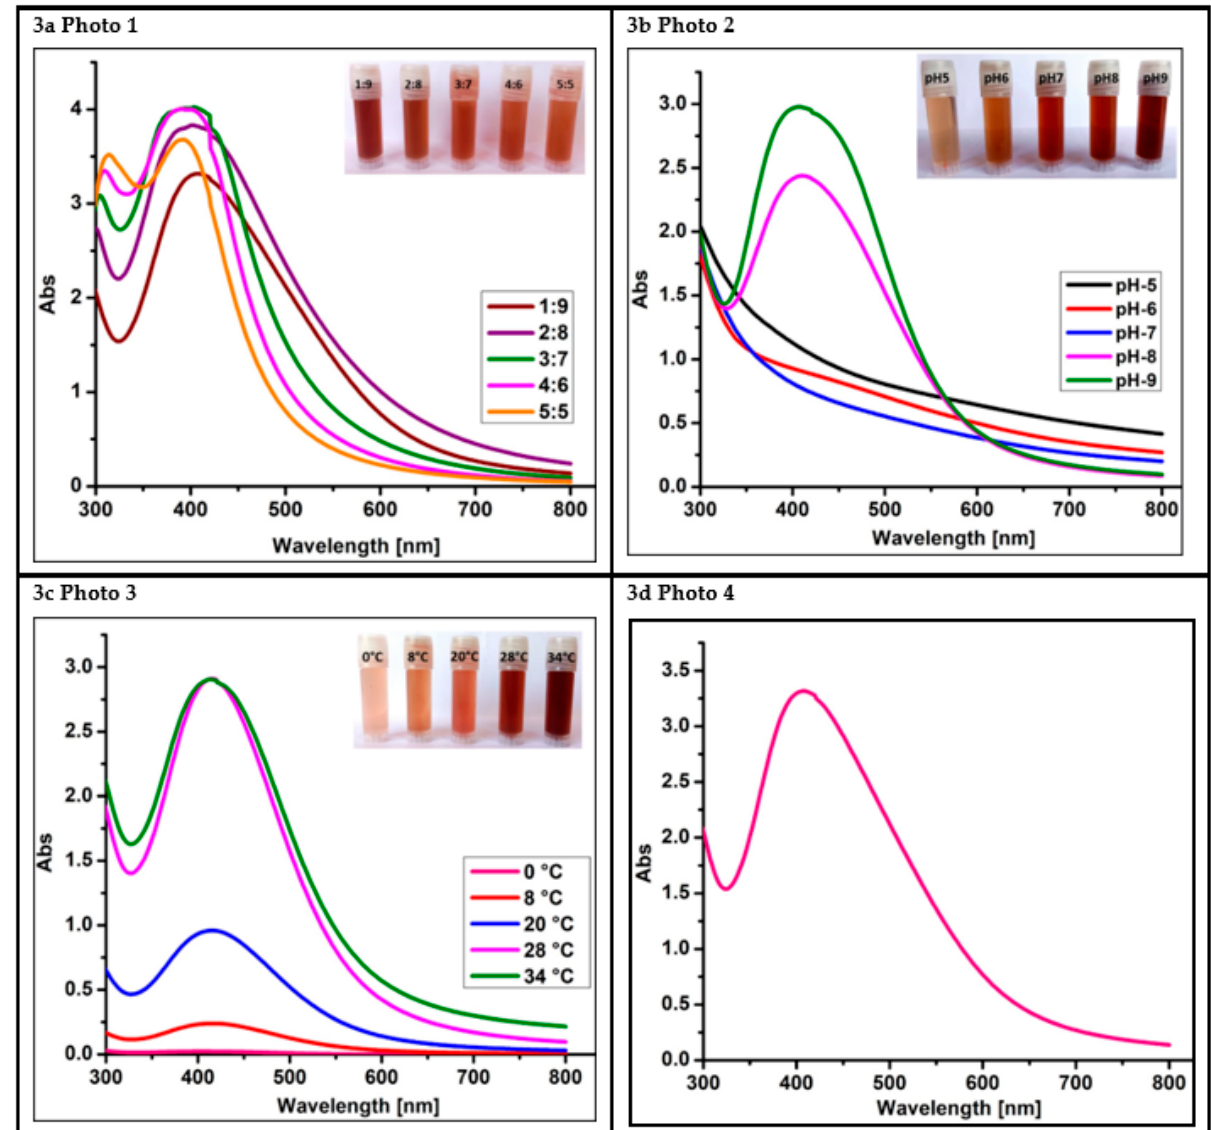
Figure 3. Color change formation and optimization of PoAgNPs. ( a ) UV absorption spectrum of PoAgNPs (fungal extract vs. silver nitrate). ( b ) Effect of pH on the synthesis of PoAgNPs. ( c ) Effect of temperature on the synthesis of PoAgNPs. ( d ) UV–visible spectroscopy produced intense SPR spectra at 410 nm in optimized conditions.